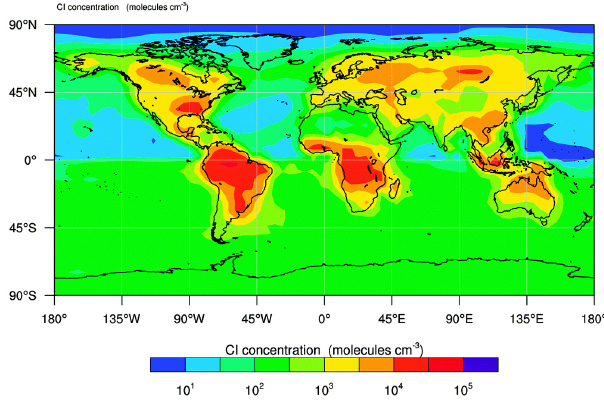
Figure 40. Global surface average model concentrations of the Criegee intermediate concentration (Taatjes et al.,